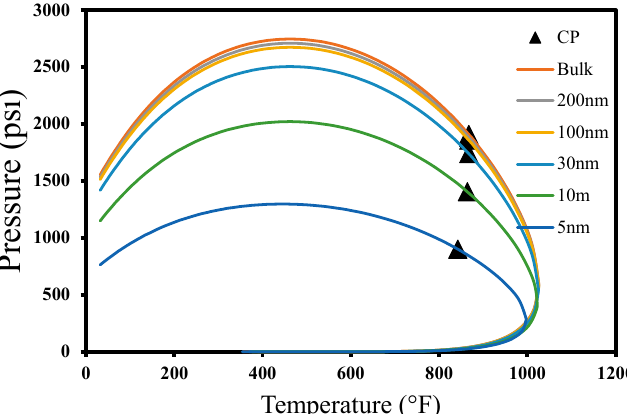
Figure 10. Base case fluid pressure change with respect to temperature for different pore sizes (CP: critical point).